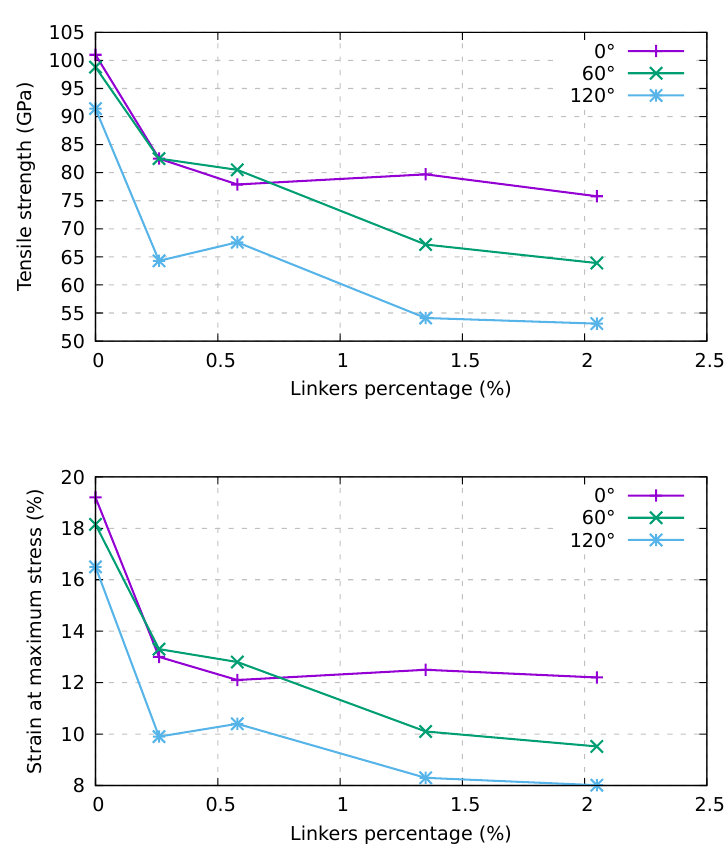
Figure 5. Dependence of the tensile strength ( top ) and of the strain at maximum stress ( bottom ) on twisting and percentage of linkers for an infinite bundle composed of ( 6,6 ) CNTs characterized by a periodic supercell of 20 nm in length. AIREBO-mod potential and a strain velocity of 1.0 Å/ps were